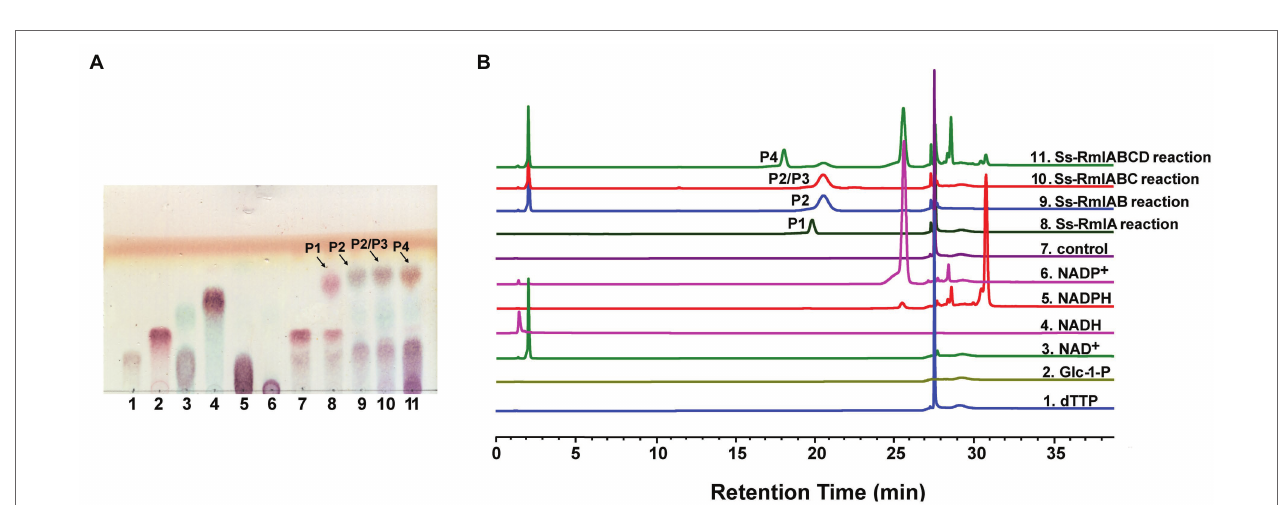
FIGURE 5 | Analysis of the reactions catalyzed by Ss-RmlABCD through TLC (A) and HPLC (B) . (A) Lane 1, dTTP; Lane 2, Glc-1-P; Lane 3, NAD + ; Lane 4, NADH; Lane 5, NADPH, Lane 6, NADP + , Lane 7, reaction control containing dTTP and Glc-1-P; Lane 8, reaction containing dTTP, Glc-1-P, and Ss-RmlA; Lane 9, reaction containing dTTP, Glc-1-P, NAD + , Ss-RmlA, and Ss-RmlB; Lane 10, reaction containing dTTP, Glc-1-P, NAD + , Ss-RmlA, Ss-RmlB, and Ss-RmlC; Lane 11, reaction containing dTTP, Glc-1-P, NAD + , NADPH, Ss-RmlA, Ss-RmlB, Ss-RmlC, and Ss-RmlD. The speculated products of Ss-RmlA, Ss-RmlB, Ss-RmlC, and Ss-RmlD are labeled as P1, P2, P3, and P4, respectively. (B) HPLC profile of the samples analyzed in (A) (Glc-1-P had no ultraviolet absorption under the analytical condition and thus could not be